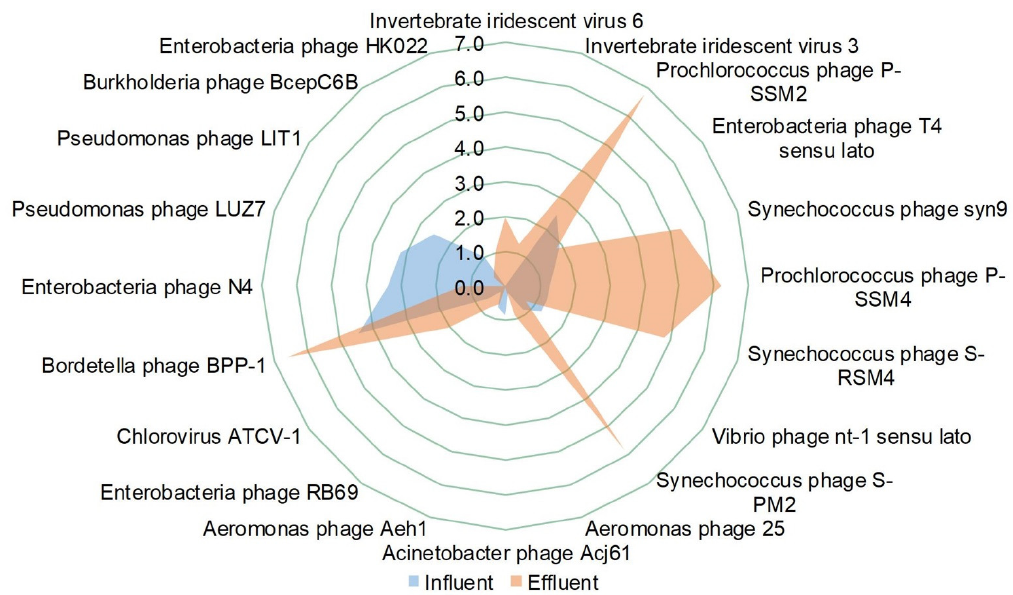
Figure 4. Diversity in percentage relative abundance of the viral taxonomy in the influent and effluent samples. The relative abundance was calculated by normalizing the sequence reads of each virus taxon to the total number of virus-associated sequences reads in the respective metagenome.